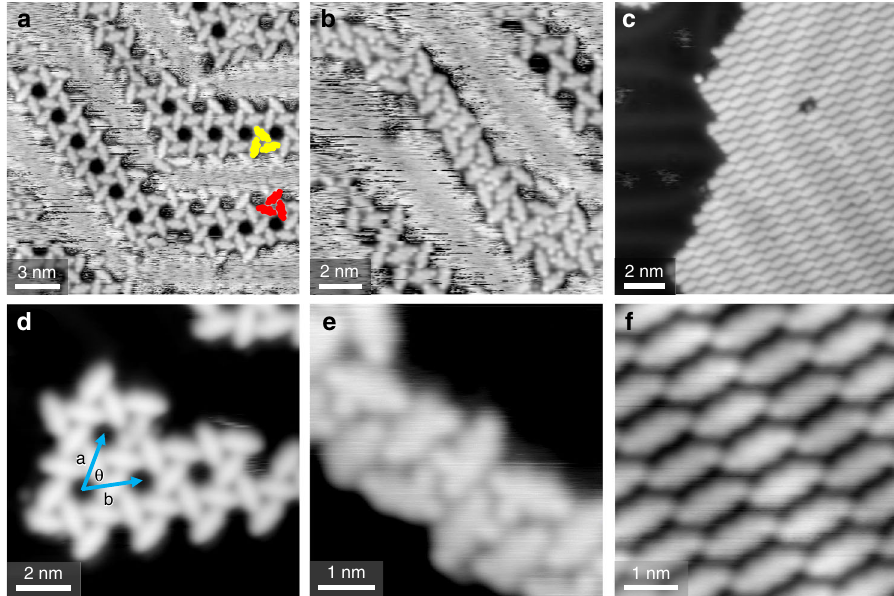
Fig. 2 STM images of self-assembled structures observed by depositing 3,9-Br 2 PXX onto a Au(111) surface. a , d Majority kagome structure (phase 1) formed at low molecular coverage. Domains of opposite chirality are indicated by red/yellow highlights in a and the parameters of the surface unit cell are shown in d . b , e Minority irregular assembly (phase 2) coexisting with the kagome structure at low molecular coverage. c , f Compact assembly (phase 3) that develops at higher molecular coverage. STM images a and b were acquired at 77 K, c – f at 7 K.